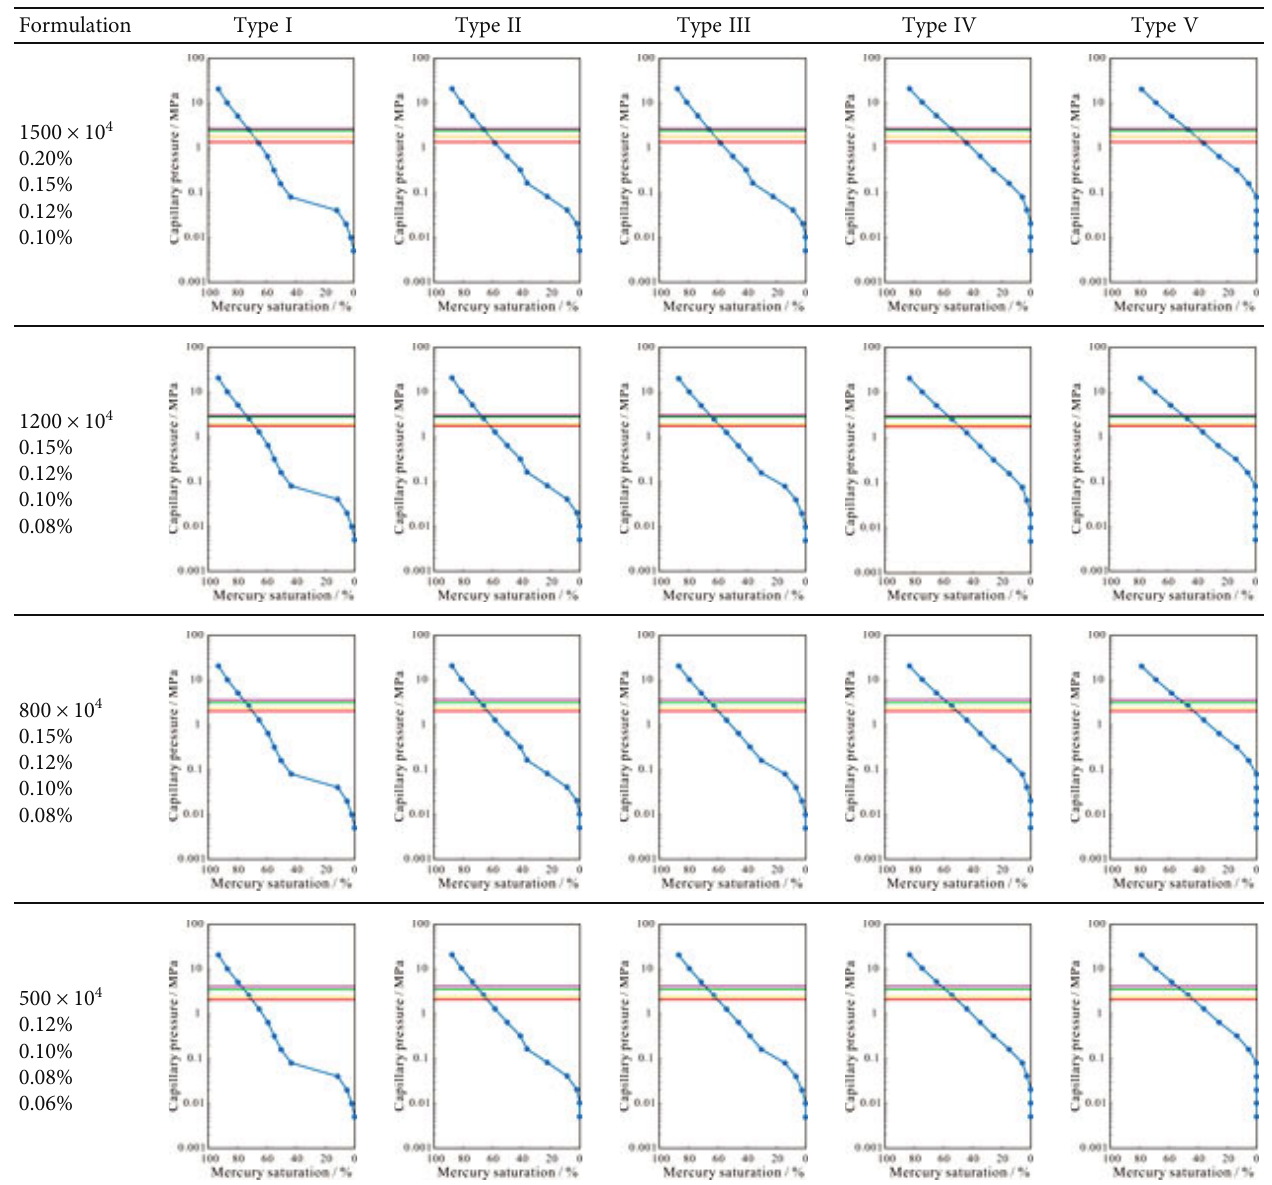
Table 5: Plate of the matching relationship between polymer solutions and di ff erent reservoir